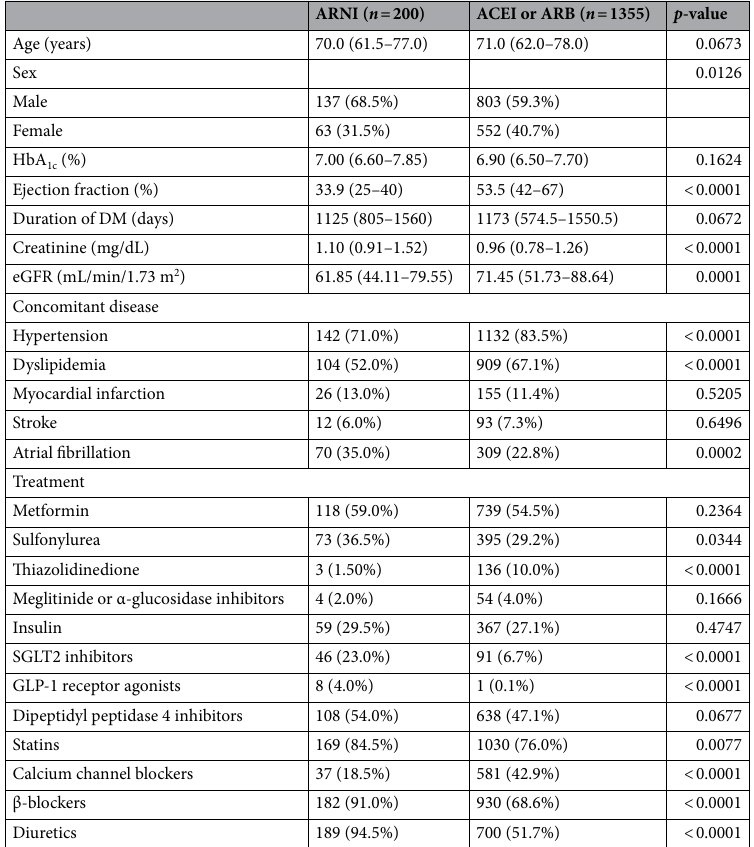
Table 1. Baseline characteristics of patients with diabetes (overall and in the treatment